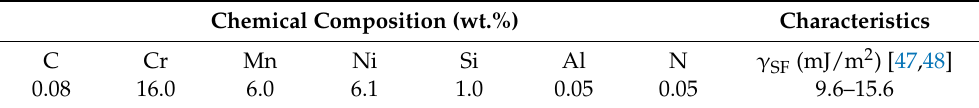
Table 1. CrMnNi16-6-6 Steel.